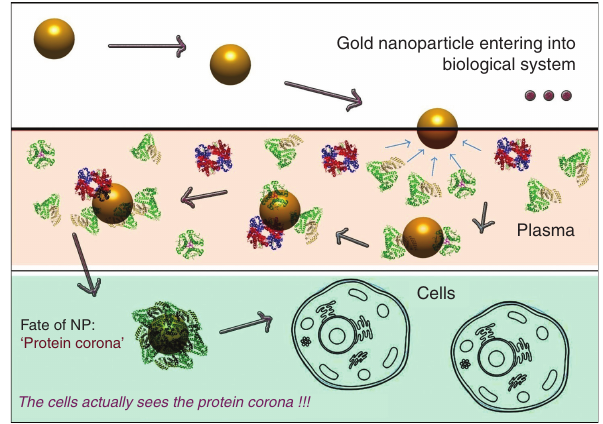
Figure 1 The fate of a gold NP in biological environment. Before reaching the target, the NP encounters various proteins and other biomolecules, which progressively get adsorbed on the surface forming a bimolecular corona. The cells only see the corona rather than the NP